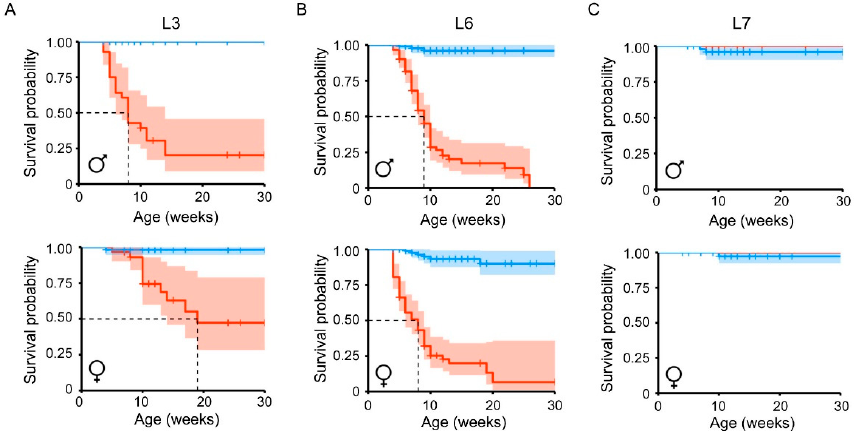
Figure 2. Survival estimates of Flag-hERR γ transgenic lines. Survival of both males and females from each of the three cardiac-specific hERR γ -Tg mouse transgenic lines was estimated by performing a Kaplan–Meier analysis for which the log rank test was used. L3 ( A ), L6 ( B ), and L7 ( C ); 80 to 202 animals per transgenic line and sex were used for the analysis.